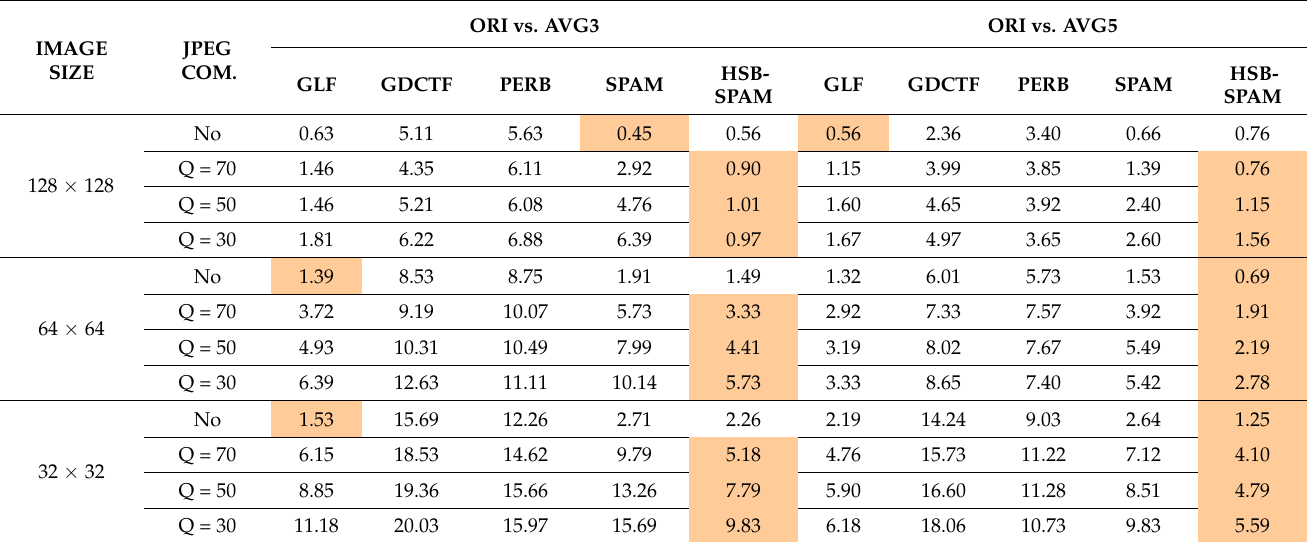
Table 2. Percentage of detection error on AVG3 and AVG5 images.